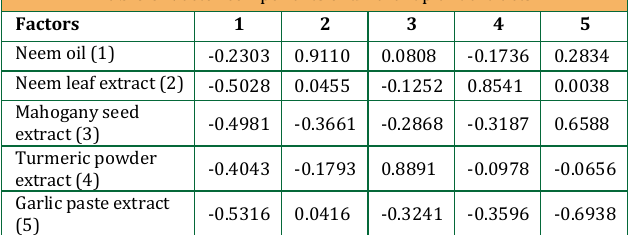
Table 6: Vector components of different plant extracts